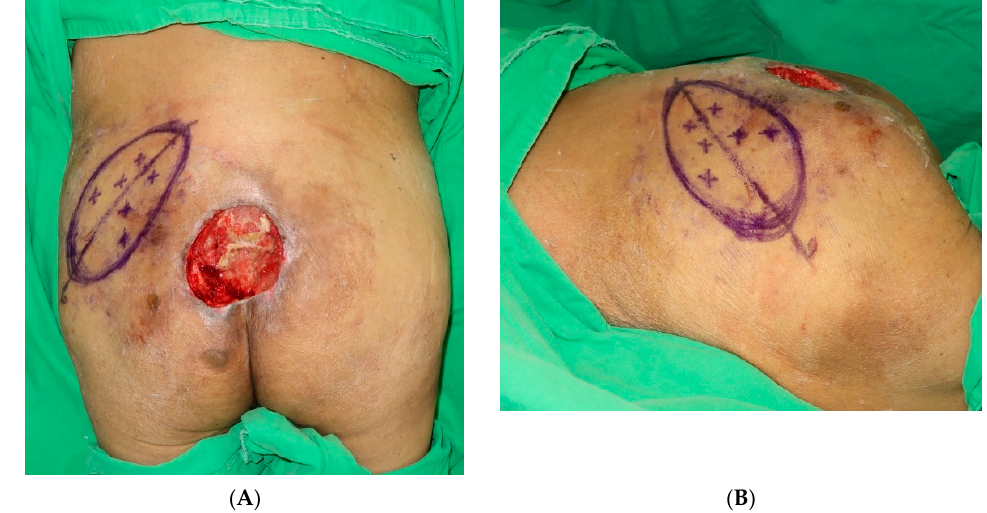
Figure 1. ( A ) A hypothetical line was drawn between the posterior superior iliac spine (PSIS) and the lateral border of the great trochanter on the side of the buttock from which the SGAP flap was planned to be harvested. ( B ) A hypothetical line was drawn between the posterior superior iliac spine (PSIS) and the lateral border of the great trochanter on the side of the buttock from which the SGAP flap was be harvested.